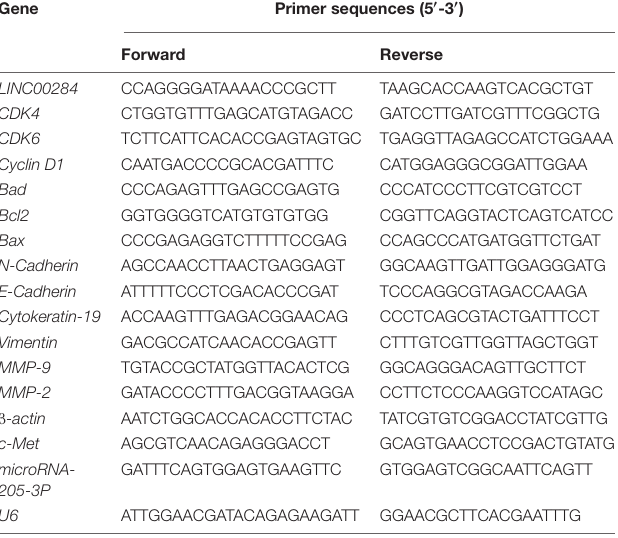
TABLE 2 | Primer sequences for RT-qPCR.